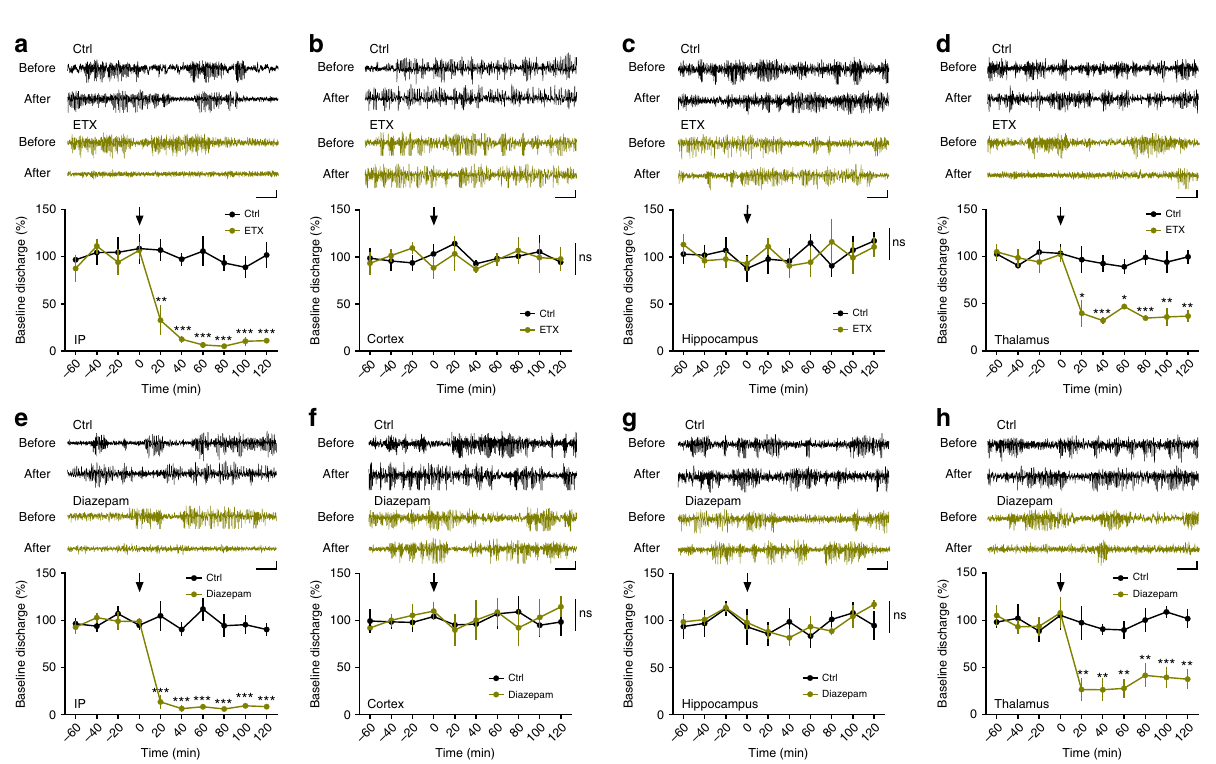
Fig. 2 Absence seizure in NLG2 KO mice involves GABAergic transmission in the thalamus. a Sample traces of EEG recordings and summary graph showing signi fi cant cessation of SWDs in NLG2 KO mice with systemic injection of ETX (200 mg/kg) compared to control (Ctrl, 0.3% tween 80) ( p < 0.0001, ETX: n = 8, Ctrl: n = 8, signi fi cant difference at each post-injection time point). b – d Sample traces of EEG recordings and summary graph of SWDs in NLG2 KO mice locally injected with either 1 μ l 100 mg/ml ETX or 0.3% tween 80 control solvent (Ctrl) to the cortex ( b ), hippocampus ( c ), or thalamus ( d ) showing signi fi cant cessation of SWDs in thalamus injected mice ( p < 0.0001, ETX: n = 5, Ctrl: n = 4, signi fi cant difference at each post- injection time point), but not in cortex ( p = 0.5226, ETX: n = 5, Ctrl: n = 8) or hippocampus ( p = 0.7673, ETX: n = 7, Ctrl: n = 7) injected mice. e Sample traces and summary graph showing signi fi cant cessation of SWDs in NLG2 KO mice systemically injected with 1 mg/kg diazepam compared to saline (Ctrl) ( p < 0.0001, Diazepam: n = 6, Ctrl: n = 7, signi fi cant difference at each post-injection time point). f – h Sample traces and summary graphs of SWDs in NLG2 KO mice locally injected with either 1 μ l 5 mg/ml diazepam or saline (Ctrl) to the cortex ( f ), hippocampus ( g ), or thalamus ( h ) showing signi fi cant cessation of SWDs in the thalamus injected mice ( p < 0.0001, Diazepam: n = 6, Ctrl: n = 7, signi fi cant difference at each post-injection time point), but not in the cortex ( p = 0.9265, Diazepam: n = 6, Ctrl: n = 8) or hippocampus ( p = 0.5791, Diazepam: n = 5, Ctrl: n = 7) injected mice. Arrow indicates the time for injection. Scale bars: 3 s/100 μ V. Data in a – h represent mean ± SEM. ns nonsigni fi cant. * p < 0.05, ** p < 0.01, *** p < 0.001 with two-sided t -test. Source data are provided as a Source Data fi le. ETX alleviates behavior de fi cits in NLG2 KO mice . Previous nRT-thalamic GABAergic synapse may underlie the reduced inhibitory synaptic transmission and SWDs in the thalamus. studies showed that NLG2 KO mice spent less time in the center Because the thalamus is a large heterogenous brain area, we also area in an open fi eld, suggesting an anxiety-like behavior 41 , but the underlying mechanism is unknown. Clinical data indicate that recorded sEPSC and sIPSC from neurons in the posterior (PO) anxiety is associated with epilepsy and up to 60% of patients with nucleus of the thalamus but found no signi fi cant differences chronic epilepsy have various mood disorders including depres- between WT and NLG2 KO mice (Supplementary Fig. 6), sug- sion and anxiety 42 – 44 . Associations were also found between the gesting that the ventrobasal thalamic VPL/VPM, but not the PO anxiety disorders and ASD 45 . These results suggest that the SWDs region, is the main target of the NLG2 effect. NATURE COMMUNICATIONS| (2020) 11:3744